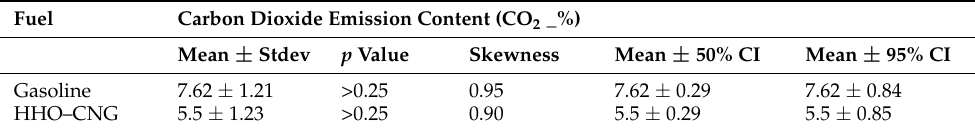
Table 6. Average CO 2 emission contents for 50% and 95% confidence intervals.